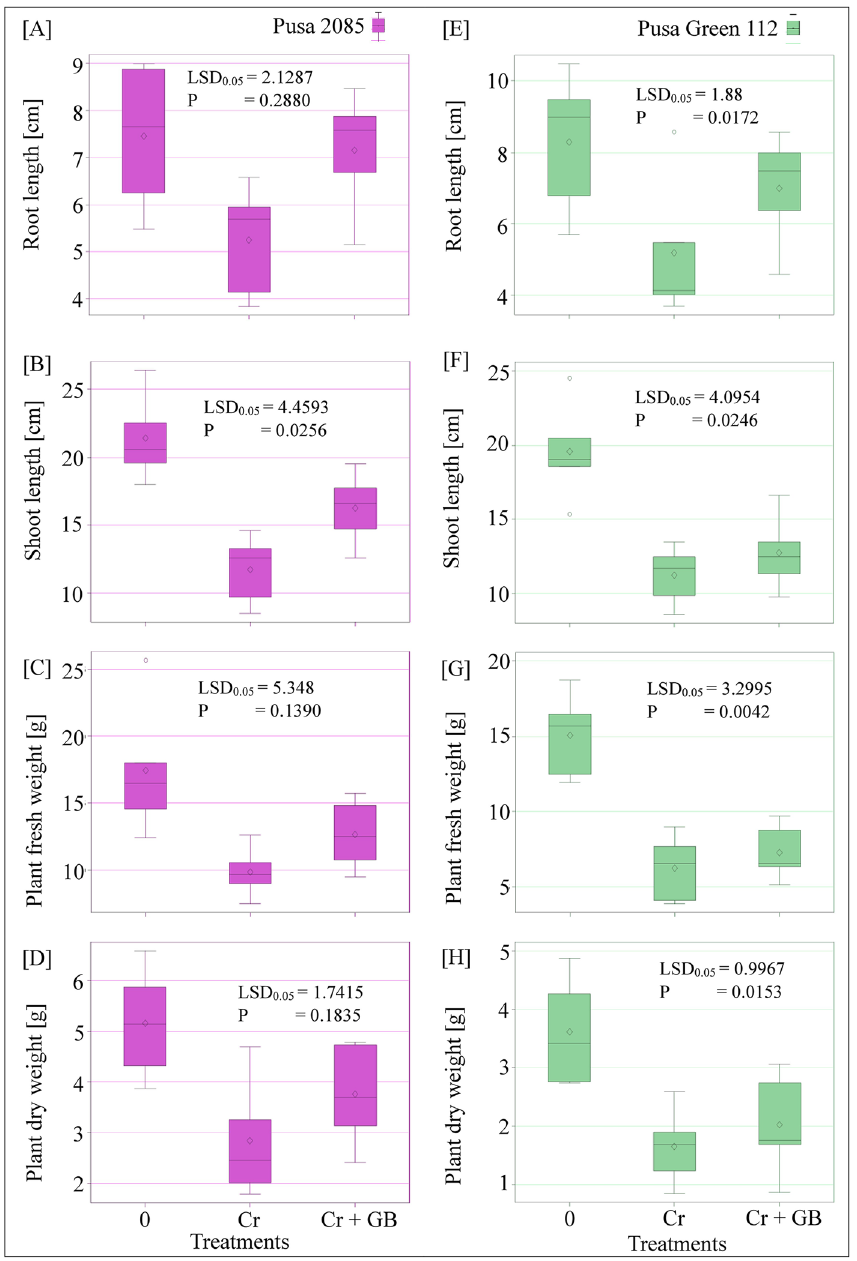
Figure 5. Box plot distribution showing the morphological attributes of both chickpea cultivars (Pusa 2085 and Pusa Green 112) grown (in pots) in the presence of 0 and 120 µM Cr and 120 µM Cr + 100 mM glycine betaine (GB) at 42 days after sowing. Least significant differences (LSD 0.05 ) was calculated for all the treatments using SAS 9.4